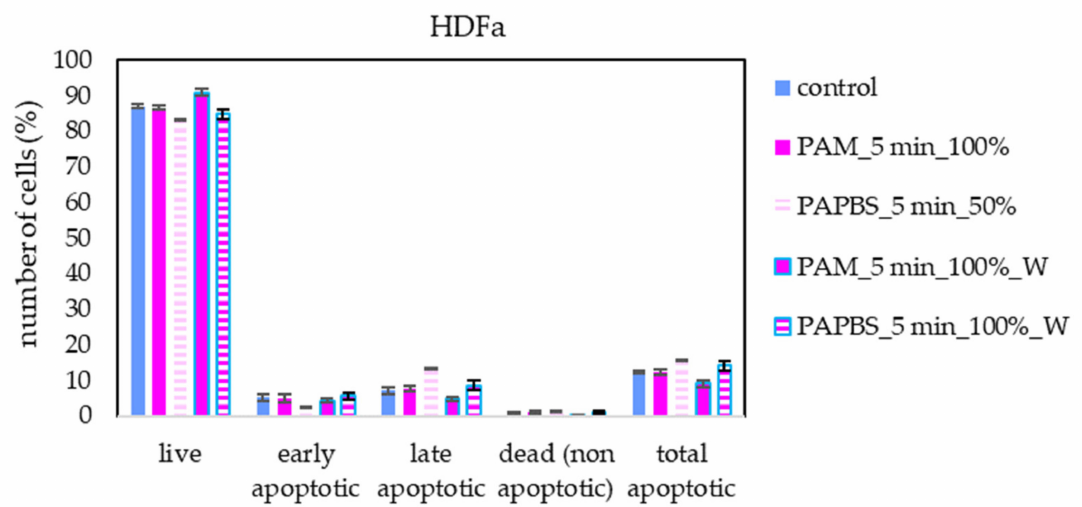
Figure 8. The effect of PAL on apoptosis induction in human dermal fibroblasts HDFa, measured 24 h after PAL application. Plasma-activated medium (PAM) or plasma-activated PBS (PAPBS) activated for 5 min in 100% or 50% concentration were used. Time of PAL action was 24 h (without blue frames) or 30 min, after which PAL were replaced with untreated medium (“washing”, W, blue frames). No significant change was